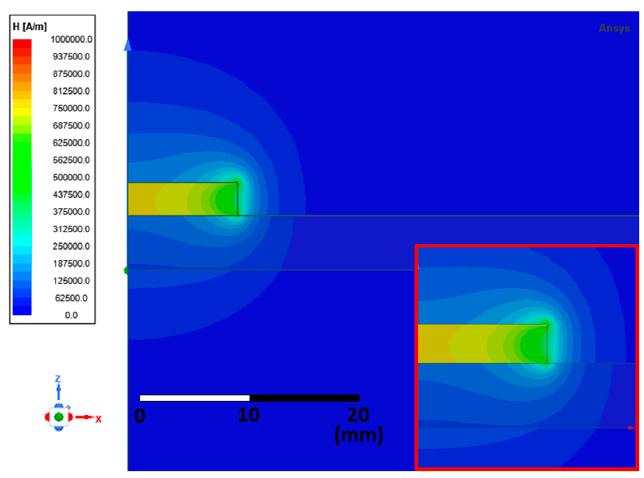
Figure 10. The calculated magnetic field distribution—Magnetic field intensity H (A.m − 1 ). The view in detail is shown in the inset.